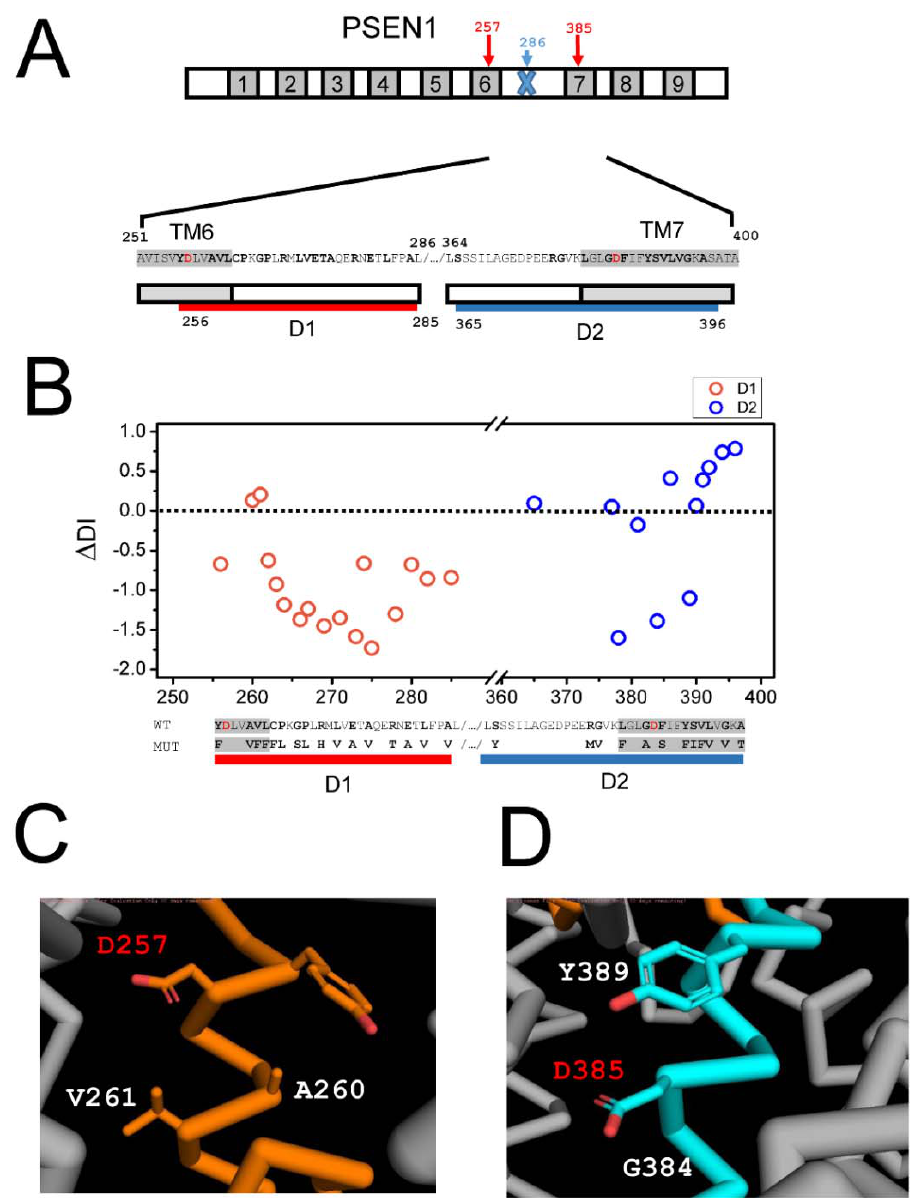
Figure 3. Effects of FAD mutations in PS1 on the stability of the APP complex with γ‐ secretase. ( A ) Bar diagram shows the domain structure of PS1 with locations of catalytic aspartates (D257 and D385) and the location of endoproteolytic cleavage site (L286) indicated. The sequences of the D1 (A251 ‐ L286) and D2 regions (L364 ‐ A400) are indicated. Transmembrane domains are shown in grey; positions that mutated in FAD are shown in bold font; catalytic aspartates are shown in red font. Red bar (D1) and blue bar (D2) show the boundaries of the mutated region that was analyzed. ( B ) Calculated difference in the disorder index ( Δ DI) for FAD mutants is shown for the D1 region (red circles) and the D2 region (blue circles). ( C ). High ‐ resolution structural model of the γ‐ secretase active site, with positions of V261 and A260 shown relative to the catalytic aspartate D257. ( D ). High ‐ resolution structural model of the γ‐ secretase active site, with positions of Y389 and G384 shown relative to the catalytic aspartate D385.